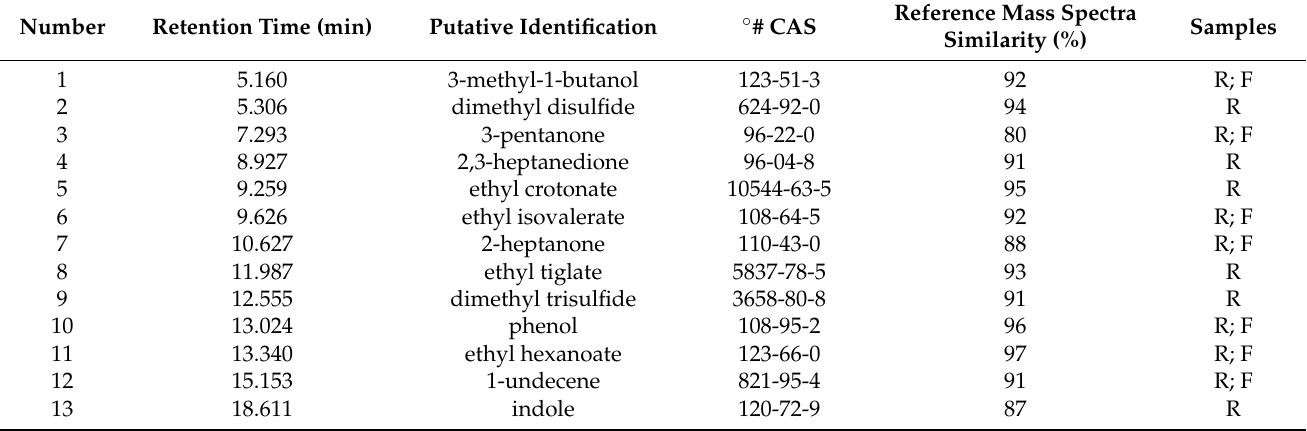
Table 2. SPME-GC/MS analysis of fish samples’ headspace. List of volatile organic compounds (VOCs) most correlated with sample degradation. For each VOC, the retention time, the CAS number ( ◦ # CAS) and the reference mass spectra similarity are specified. In the Samples column, R indicates samples stored and analyzed at 25 ◦ C, while F indicates samples stored at 4 ◦ C and analyzed at room temperature (25 ◦